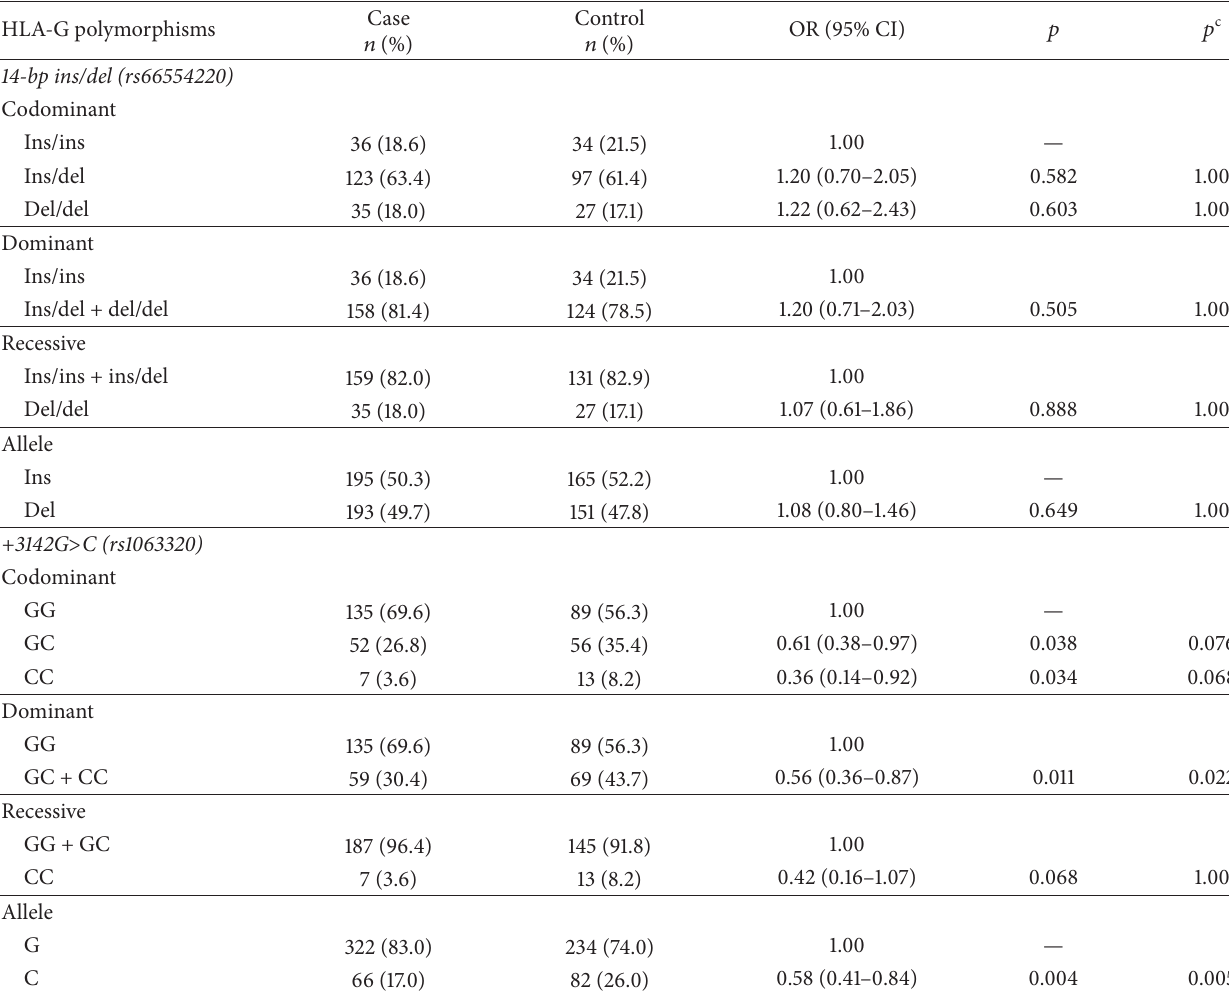
Table 1: Association of HLA-G polymorphisms and the risk of